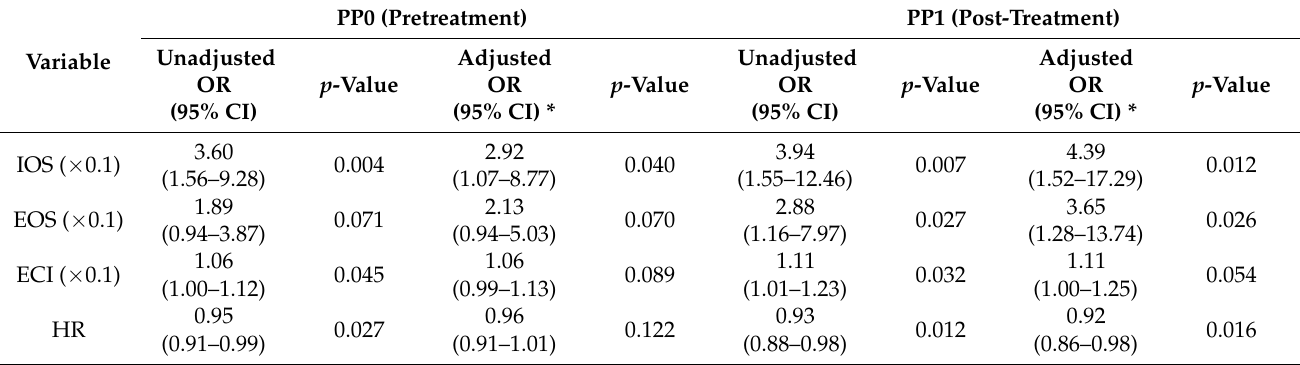
Table 3. Association between elastographic parameters and spontaneous preterm delivery at < 32 weeks of